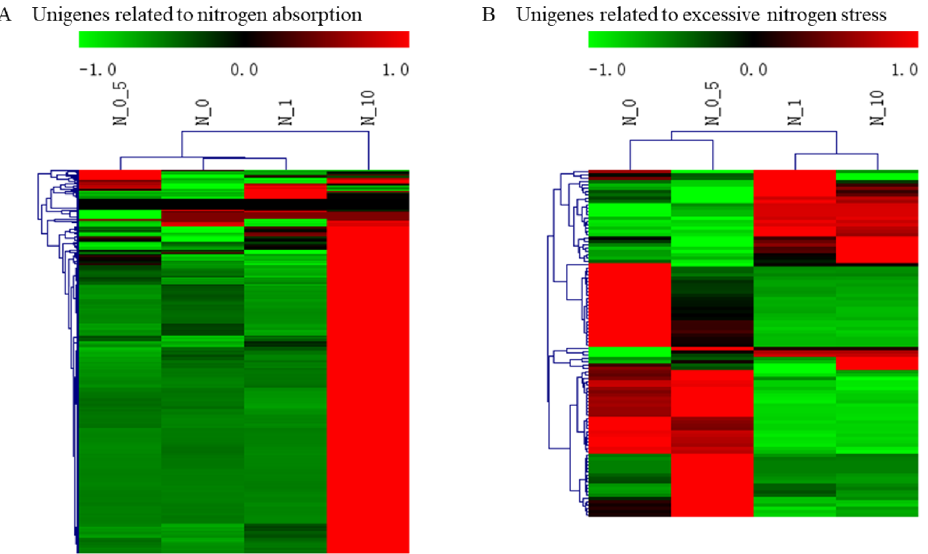
Figure 6. Heat map clustering analysis of unigenes related to nitrogen utilization and excessive nitrogen stress. ( A ) and ( B ) show the clustering of unigenes related to nitrogen utilization and excessive nitrogen stress, respectively. High-expression genes are shown in red, and low-expression genes are shown in